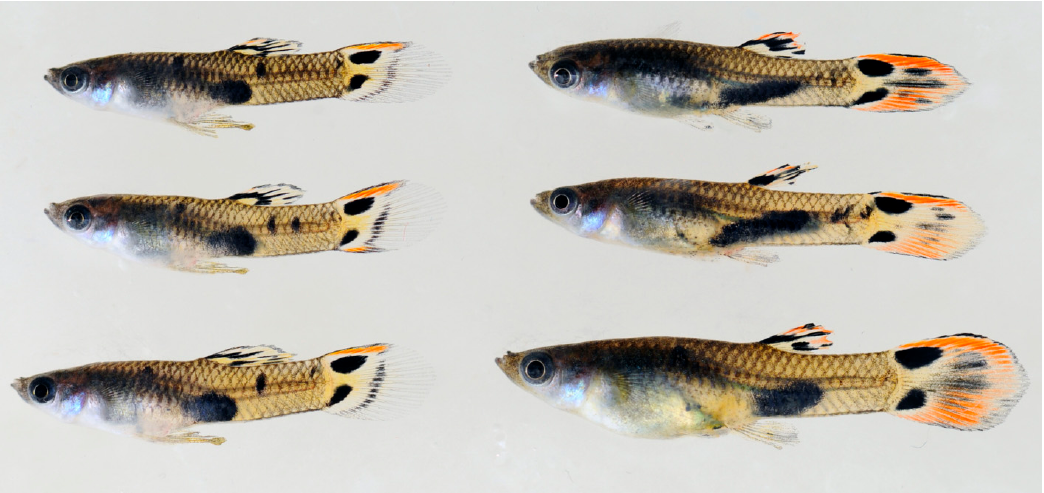
Figure 7. Untreated males ( left ) and 17-methyltestosterone treated females ( right ) of M. picta (FG strain). Hormone treated females show the complete male pigmentation pattern. For the pheno- type of untreated females see Supplementary Figure